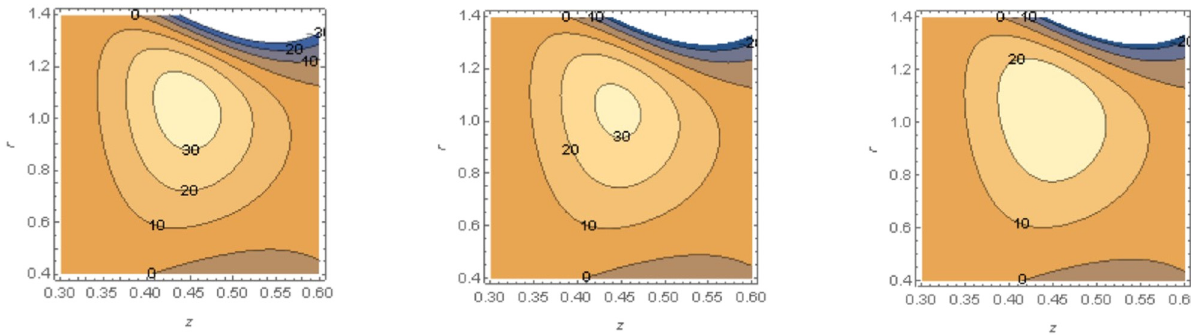
Figure 23: Various values of the wave frame streamlines of Q 3 = { 0.1, 0.2, 0.3 } at W